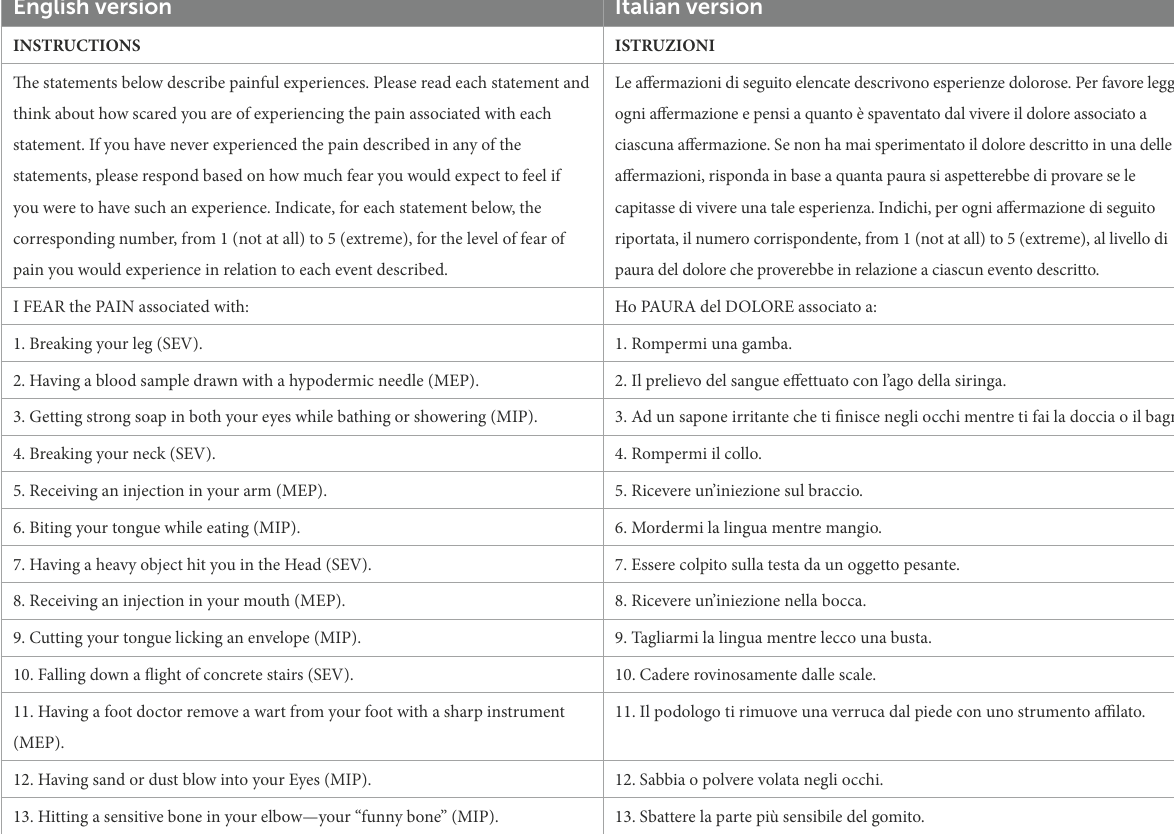
TABLE 10 Fear of Pain Questionnaire (FPQ-III short